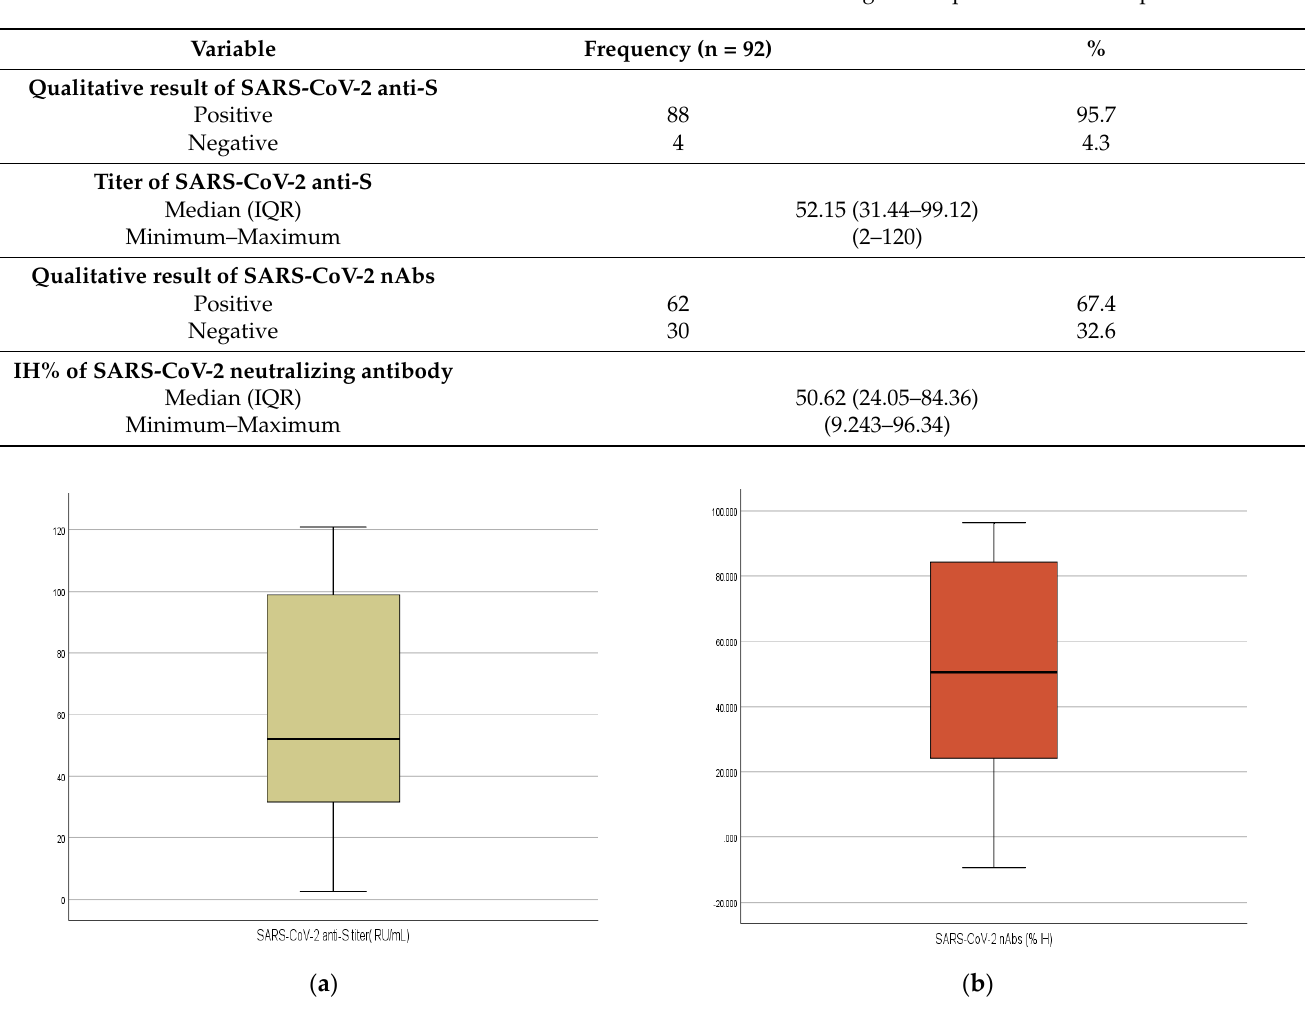
Table 1. Results of SARS-CoV-2 anti-S and nAbs among 92 Sinopharm vaccine recipients.